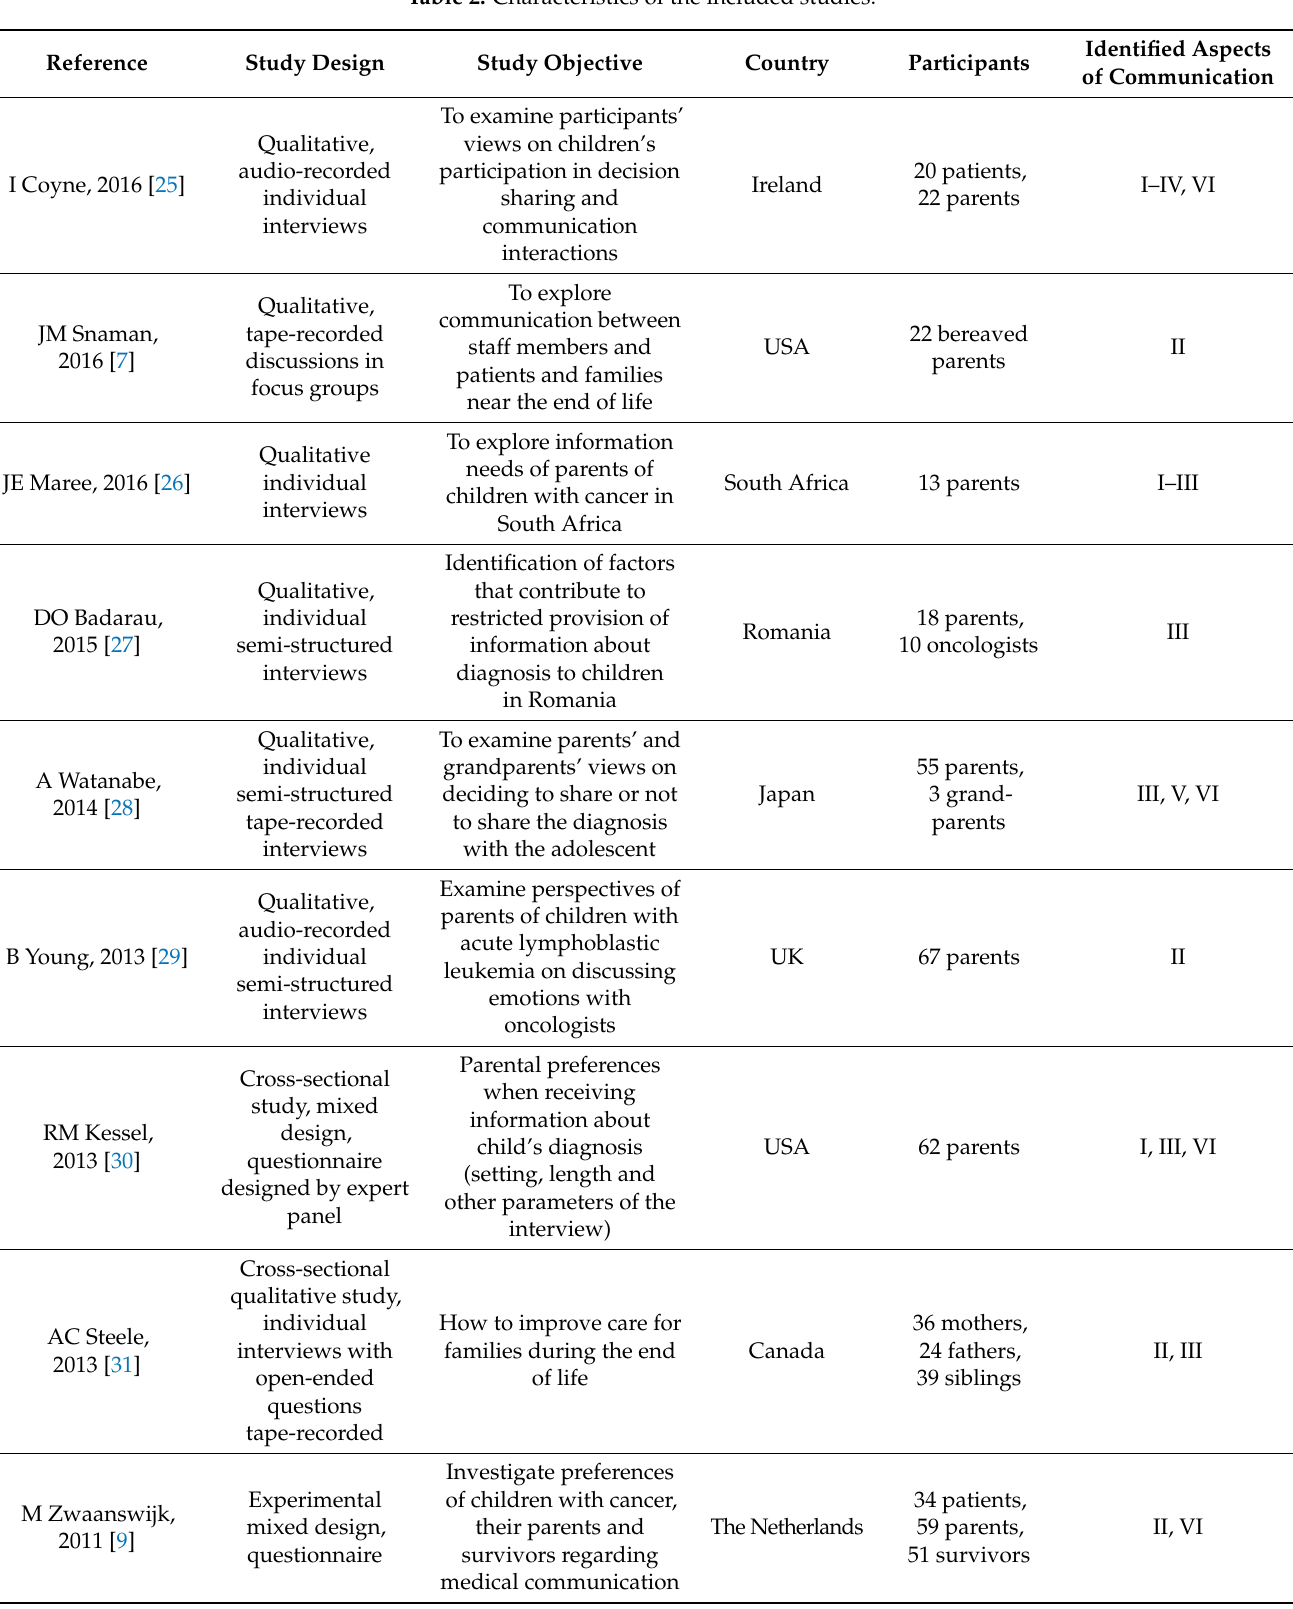
Table 2. Characteristics of the included